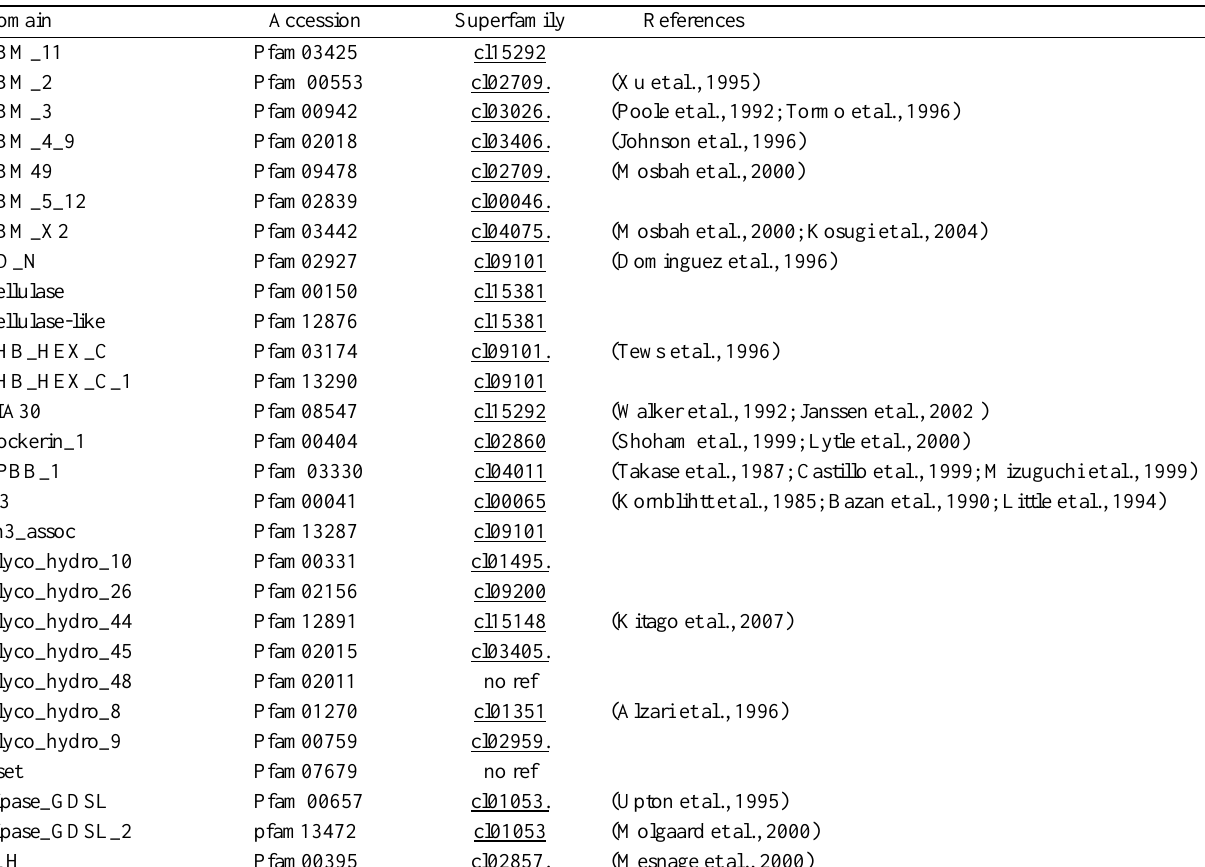
Table 1. List of protein domains with cellulase activity in goats